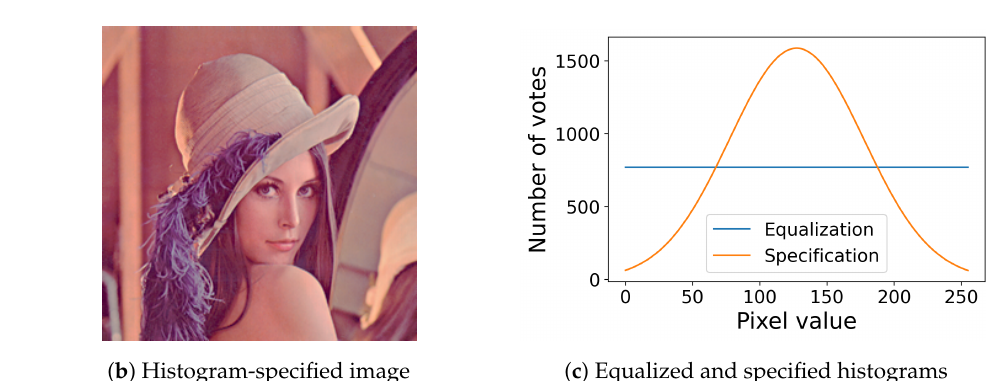
Figure 7. Exact histogram equalization and specification for a color image: ( a ) histogram-equalized image of the original color image in Figure 6a; ( b ) the histogram-specified image with a Gaussian target histogram; ( c ) equalized (blue line) and specified (orange line)